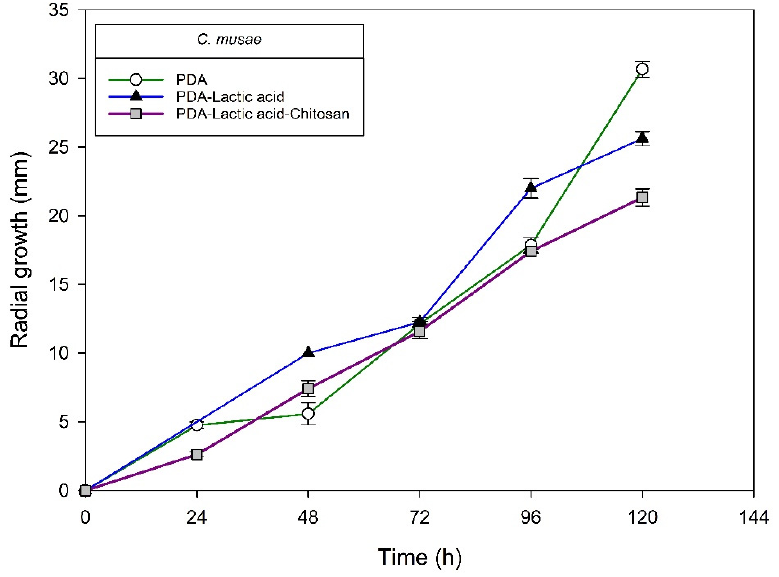
Figure 7. Colletotrichum musae isolated from anthracnose of mango. Kinetics of radial growth (mm) in medium PDA, PDA-lactic acid (0.05 M), and PDA-lactic acid (0.05 M) with 1 g L − 1 chitosan at 25 ◦ C. for two C. fructicola